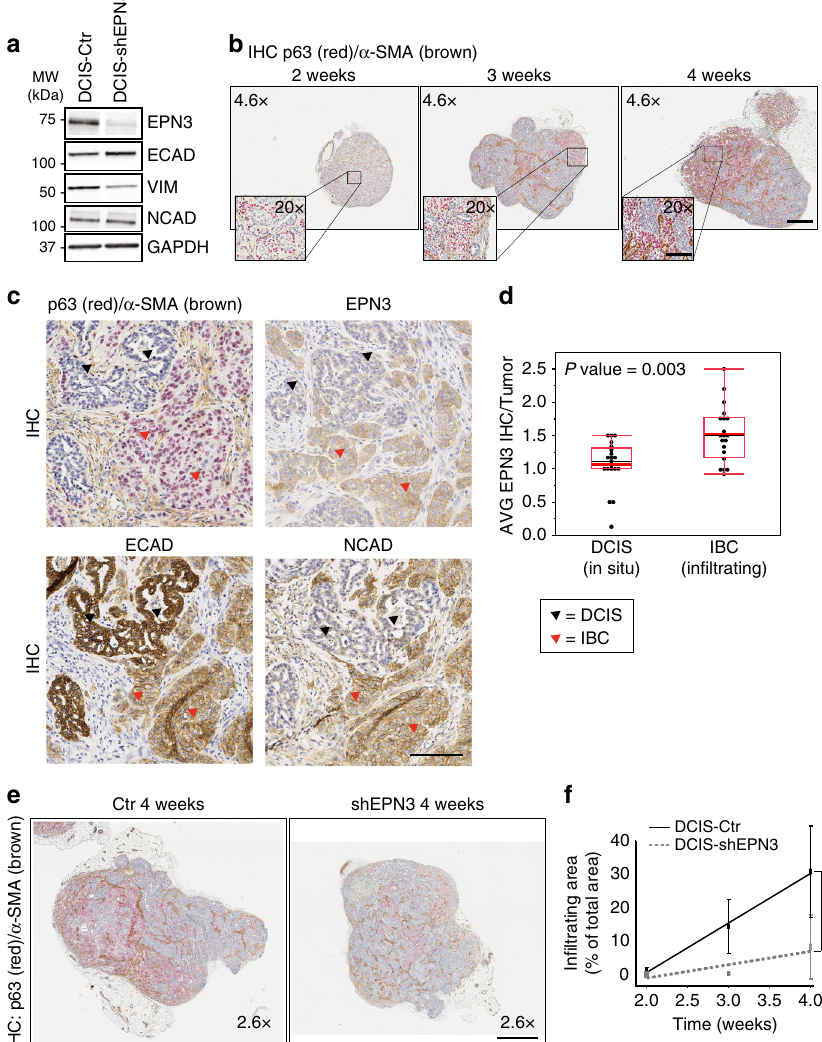
Fig. 9 EPN3 expression during the progression from in situ to invasive BC. a Expression of EMT markers in MCF10DCIS.com cells infected with control vector (DCIS-Ctr) or shEPN3 (DCIS-shEPN3) by IB with the indicated Ab. GAPDH, loading control. Left, MW markers. b IHC double staining of p63 (red)/ α -SMA (brown) in tumors grown from MCF10DCIS.com cells engrafted in the mammary fat pad over time (2 – 3 – 4 weeks). Bar, 500 µ m. Inset, magni fi cations (×20) of the indicated areas. Bar, 100 µ m. c , d Five consecutive sections of 20 DCIS-Ctr tumors derived as described in ( a ) and ( b ) were stained with H&E (not shown), p63/ α -SMA, EPN3, NCAD, or ECAD Abs. c IHC images of in situ (DCIS, black arrowheads) and in fi ltrating (IBC, red arrowheads) areas of a representative DCIS-Ctr tumor stained with the indicated Ab on consecutive sections. p63 (red) and α -SMA (brown) were double stained. Images at ×20. Bar, 100 µ m. d All the areas with clearly distinct components of DCIS present in each tumor, and adjacent IBC areas, were identi fi ed based on H&E and p63/ α -SMA staining. In these matched DCIS vs. IBC areas, EPN3 expression was evaluated by IHC using intensity scores ranging from 0 to 3 as described for TMA analysis (see “ Methods ” ), and an average score was then calculated for all the DCIS and IBC areas identi fi ed within each tumor. Box plot of the average EPN3 expression measured in DCIS and paired IBC areas of each MCF10DCIS.com-Ctr tumor at 2, 3, 4, 5 weeks ( N , number of tumors analyzed = 20). P value, Wilcoxon test. e Representative images of the double IHC staining of p63 (red)/ α -SMA (brown), in DCIS-Ctr and DCIS- shEPN3 tumors at 4 weeks. One image for each tumor is shown (×2.6). Bar, 800 µ m. The red/brown color marks the invasive areas. f Percentage of in fi ltrating areas normalized on the total tumor area was measured for each DCIS-Ctr and DCIS-shEPN3 tumor at each time point. Results at each time point represent the mean ± S.D. of at least four tumors per time point per condition (DCIS-Ctr and -shEPN3). P value, Student ’ s t test two-tailed. Source data are provided as a Source Data fi